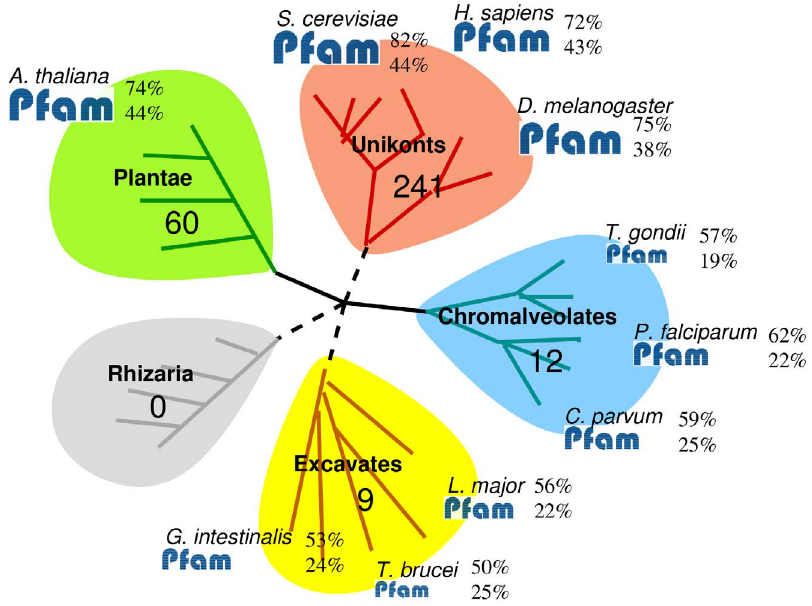
Figure 1. Number of sequenced genomes and domain coverage in the Eukaryote tree. This figure reports the number of genomes entirely sequenced in each of the 5 supergroups of the Eukaryote tree [58]. In each group, a few sequenced genomes are provided as example, along with statistics relative to Pfam domains (release 26): the proportion of proteins where at least one Pfam domain has been identified using recommended Pfam score thresholds (above), and the proportion of amino acids covered by a Pfam domain (below). Most of the genomes sequenced to date belong to the Unikont (241) and plant (60) super-groups. We can see that there is a marked difference in the protein domain coverage between these groups and the three other groups: while the proportion of proteins where at least one known Pfam domain is usually above 70% in Unikonts and plants, it lies between 50% and 60% in the other groups. Similarly, while the proportion of amino-acids covered by a Pfam domain is often above 40% in plants and Unikonts, it is around 22% in the other supergroups.